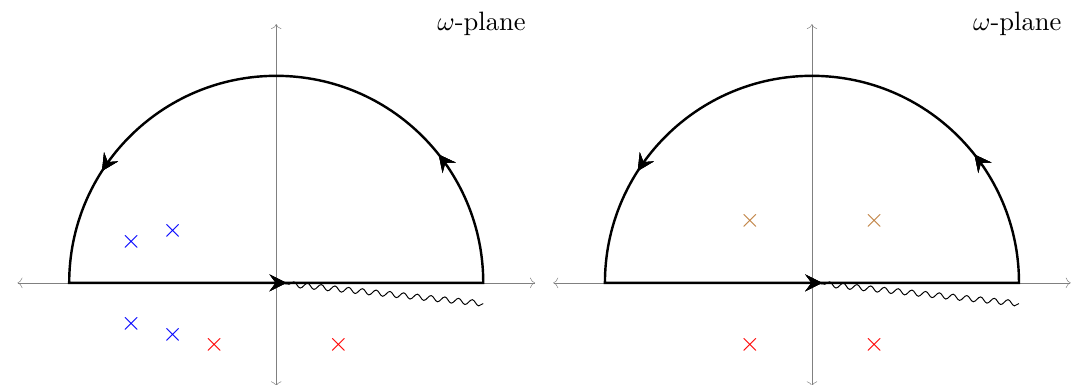
Figure 3 . The analytic structure for s -channel resonances. Left: example of the ω -poles of the momentum space amplitude T in ( ω, z ) coordinates. The red poles appear without complex conjugate partners, and denote the resonances of the amplitude. Right: ω -pole structure for the imaginary part ( T ( ω, z ) − T ∗ ( ω, z )) / 2 i . We have used the O ( N ) model to exemplify the analytic